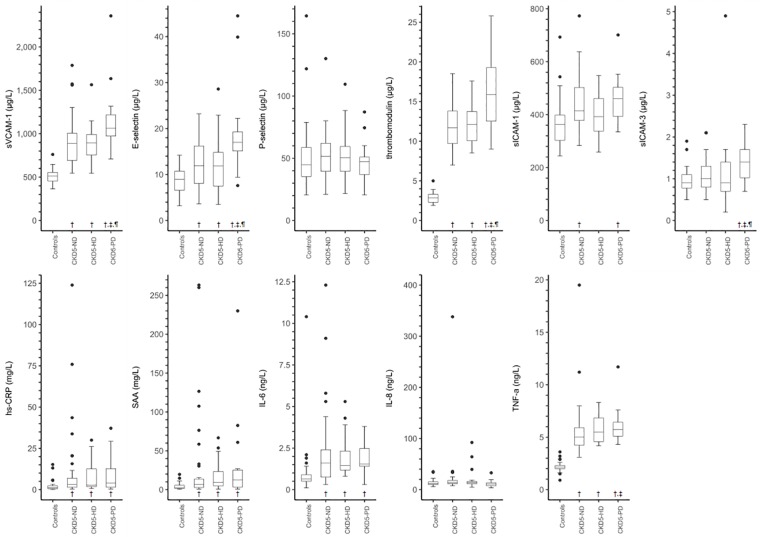
Boxplots of serum biomarkers of endothelial dysfunction and low-grade inflammation stratified according to participant group.Abbreviations: hs-CRP, high-sensitivity C-reactive protein; IL-6, interleukin 6; IL-8, interleukin 8; NA, not applicable; SAA, serum amyloid A; sICAM-1, soluble intercellular adhesion molecule 1; sICAM-3, soluble intercellular adhesion molecule 3; sVCAM-1, soluble vascular cell adhesion molecule 1; TNF-α, tumor necrosis factor alpha. Please note that in the boxplot of IL-8 levels in controls, one extreme outlier with an IL-8 level of 2469.8 ng/L was removed to improve the clarity of the graph. †
P value < 0.05 vs. controls; ‡
P value < 0.05 vs. CKD5-ND; ¶
P value < 0.05 vs. CKD5-HD based on unadjusted linear regression analyses of natural log transformed serum biomarkers.